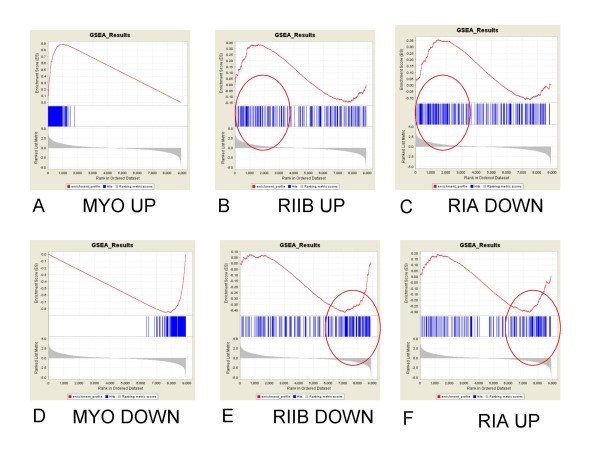
GSEA gene set analysis of PKA subunit regulated genes versus human myotube differentiation data. The top 250 RIα, RIIβ, and myotube significantly up- and down-regulated genes are graphically displayed as indicated across a rank ordered distribution of all myotube versus myoblast changes in gene expression. The red curves report the values of a modified Kolmogorov-Smirnoff cumulative statistic [50] across the distribution of all changes in gene expression (of the myotube dataset). The peak of the curve (either above or below the midpoint of zero) becomes the maximum enrichment score (ES) which is normalized by gene list size to generate a normalized enrichment score (NES) and tested for significance by permutation analysis (NOM p-val, as reported in Table 1). Myotube up- or down-regulated genelists were used as positive controls. RIIβ and RIα up- and down-regulated genes are shown to cross correlated with myotube changes in gene expression (red circles indicate areas of enrichment).